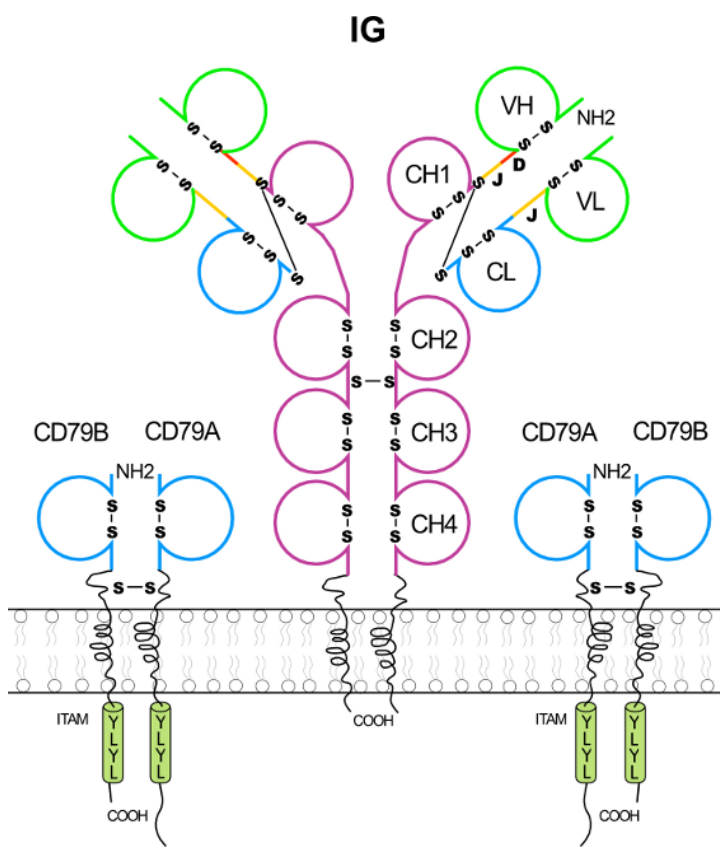
Figure 4. B cell receptor (BcR). The B cell receptor (BcR) on the surface of mature B cells comprises an immunoglobulin (IG) or antibody, here IgM, as a monomer H2L2, anchored in the membrane of the B cell (membrane IG or mIG) and the CD79 signalling coreceptors constituted of two heterodimers CD79A/CD79B (BcR = mIG + CD79 coreceptor). VH, CH1, CH2, CH3 and CH4 indicate the domains of the H-mu chains of the IgM. Depending on the light chain type, L-kappa or L-lambda, VL and CL correspond to V-kappa and C-kappa, or to V-lambda and C-lambda, respectively. ITAM motifs are indicated by the letters YLYL for tyrosyl (Y) and leucyl (L) amino acids. (With permission from M-P. Lefranc and G. Lefranc, LIGM, Founders and Authors of IMGT ® , the international ImMunoGeneTics information system ® , http://www.imgt.org).